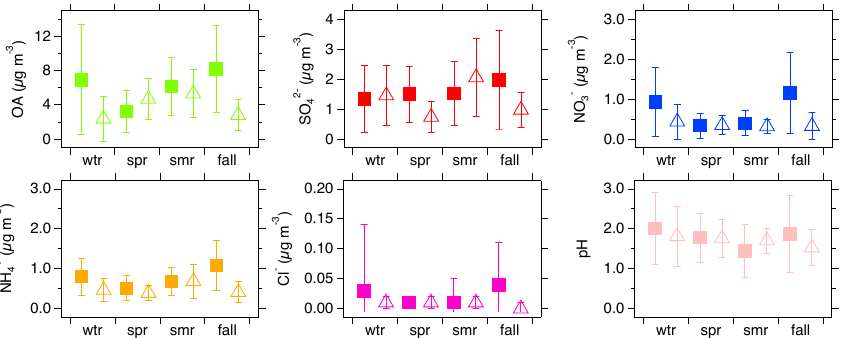
Figure 3. Seasonal averages of OA, inorganic species and pH from JST (solid squares) and LRK (open triangles). Error bars show ± 1 standard deviation. Seasons are classified into winter (wtr), spring (spr), summer (smr) and